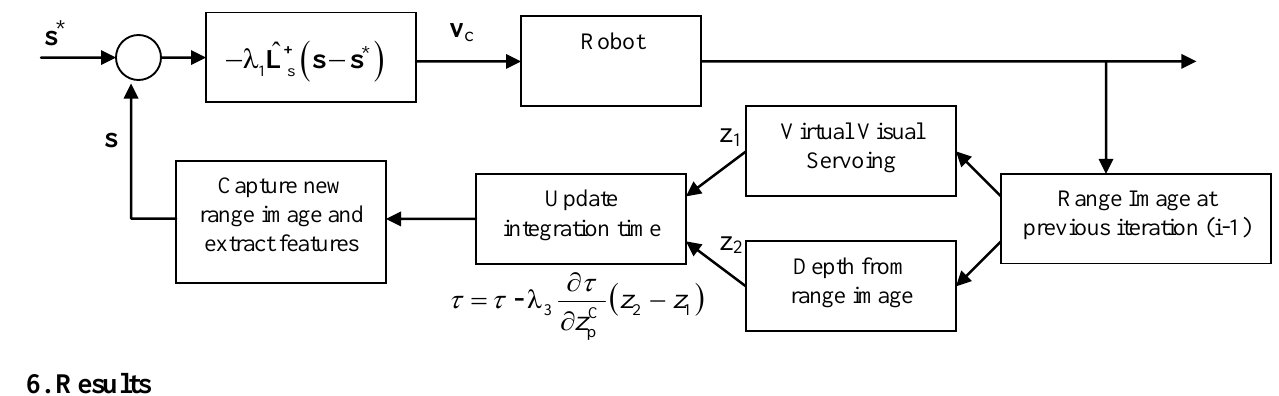
Figure 5. Block diagram of the visual servoing